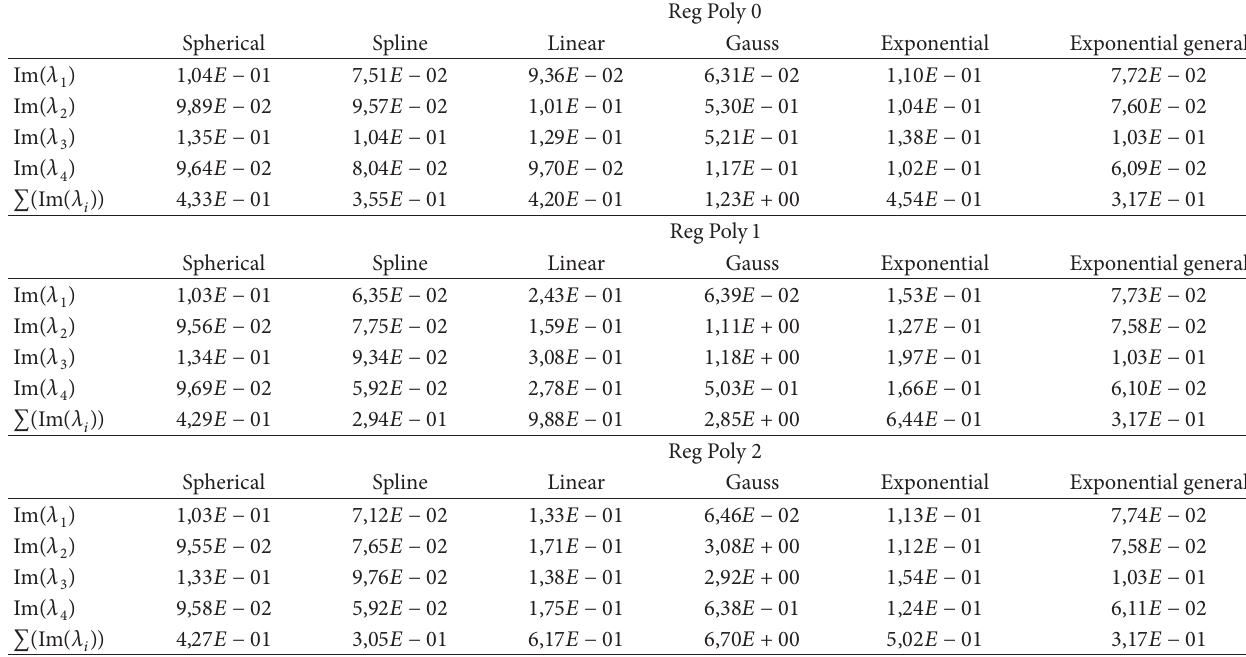
Table 9: Configuration 2: quadratic mean of absolute error on imaginary parts of eigenvalues for different regression and correlation kriging